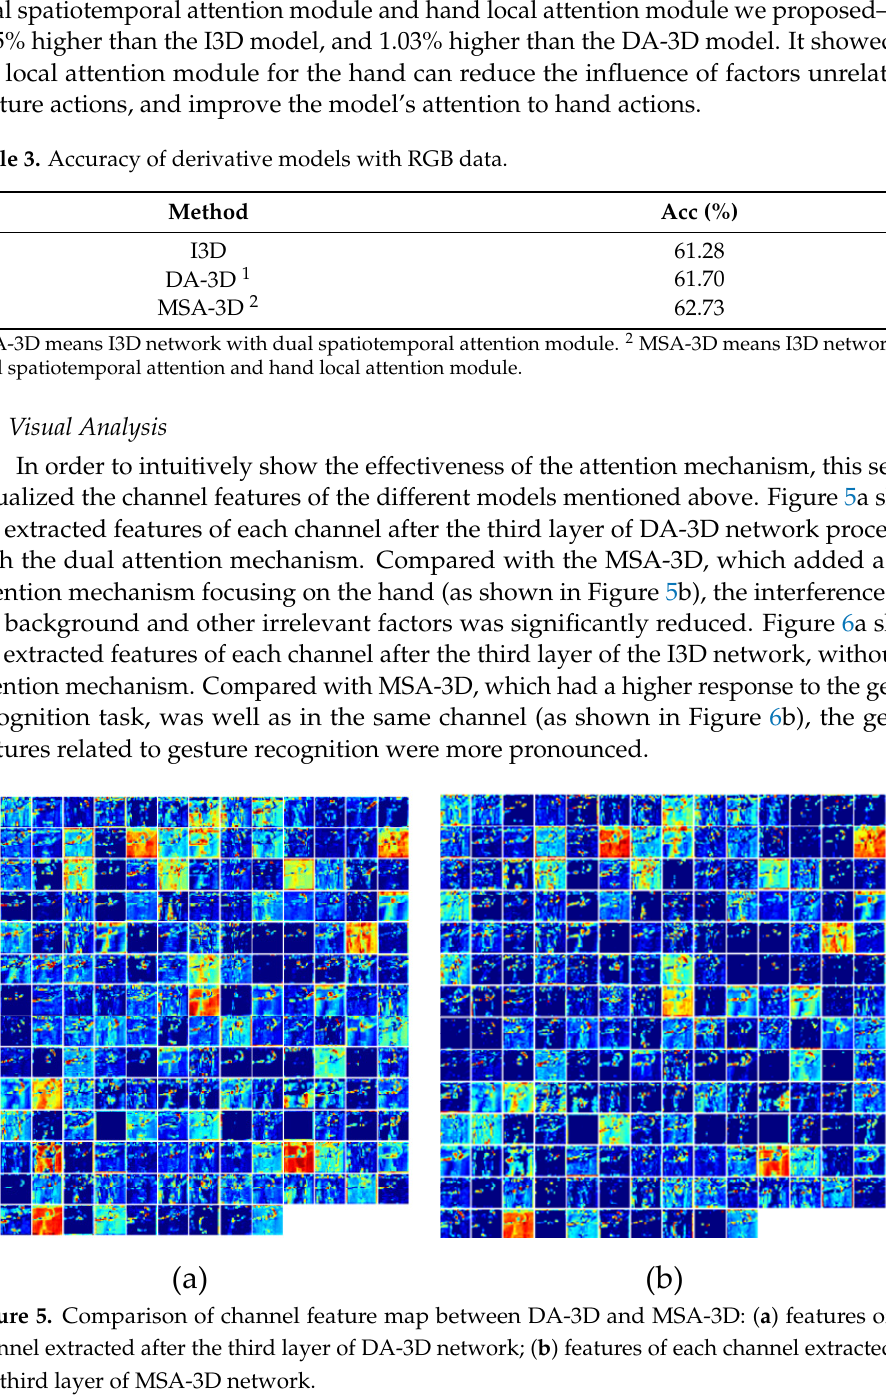
Figure 6. Comparison of channel feature map between I3D and MSA-3D: ( a ) features of each channel extracted after the third layer of I3D network; ( b ) features of each channel extracted after the third layer of MSA-3D network. 5. Conclusions This paper proposed a local attention- and dual attention-based multimodal 3D Con- volutional Network. The RGB and depth modal data provided in the IsoGD dataset and Briareo dataset, along with the hand videos generated by the RGB data, were used as in- put. The network used the I3D model based on dual spatiotemporal attention and local attention mechanisms to extract features of RGB data, and used the I3D model with dual spatiotemporal attention to extract depth data features. The extracted features were mul- tiplied and fused element-wise as the final classification result. This method achieved 68.15% accuracy on the test set of IsoGD, which outperformed the baseline model I3D we used, as well as current state-of-the-art methods. This further illustrated the effectiveness